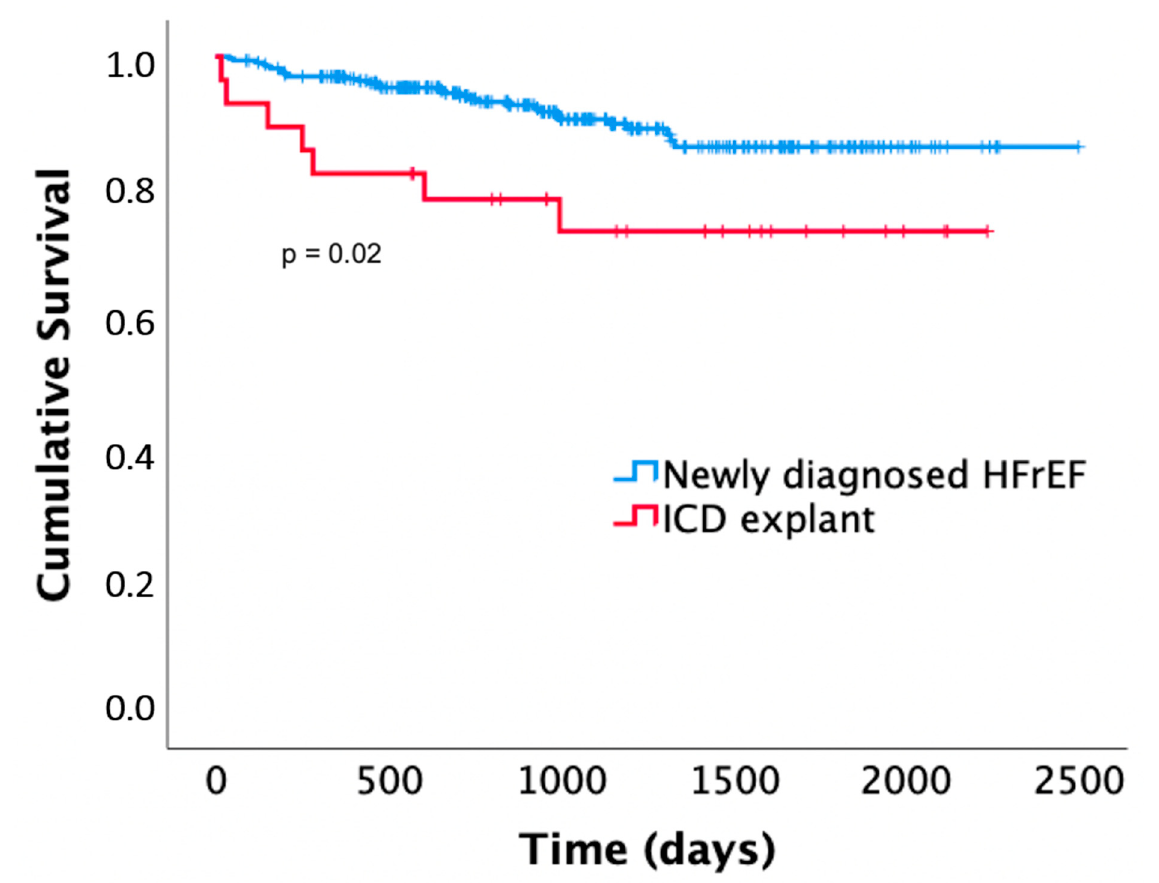
Figure 4. Kaplan–Meier survival curves of patients receiving the WCD for newly diagnosed heart failure with reduced ejection fraction (HFrEF) compared to patients receiving the WCD after ICD explantation.